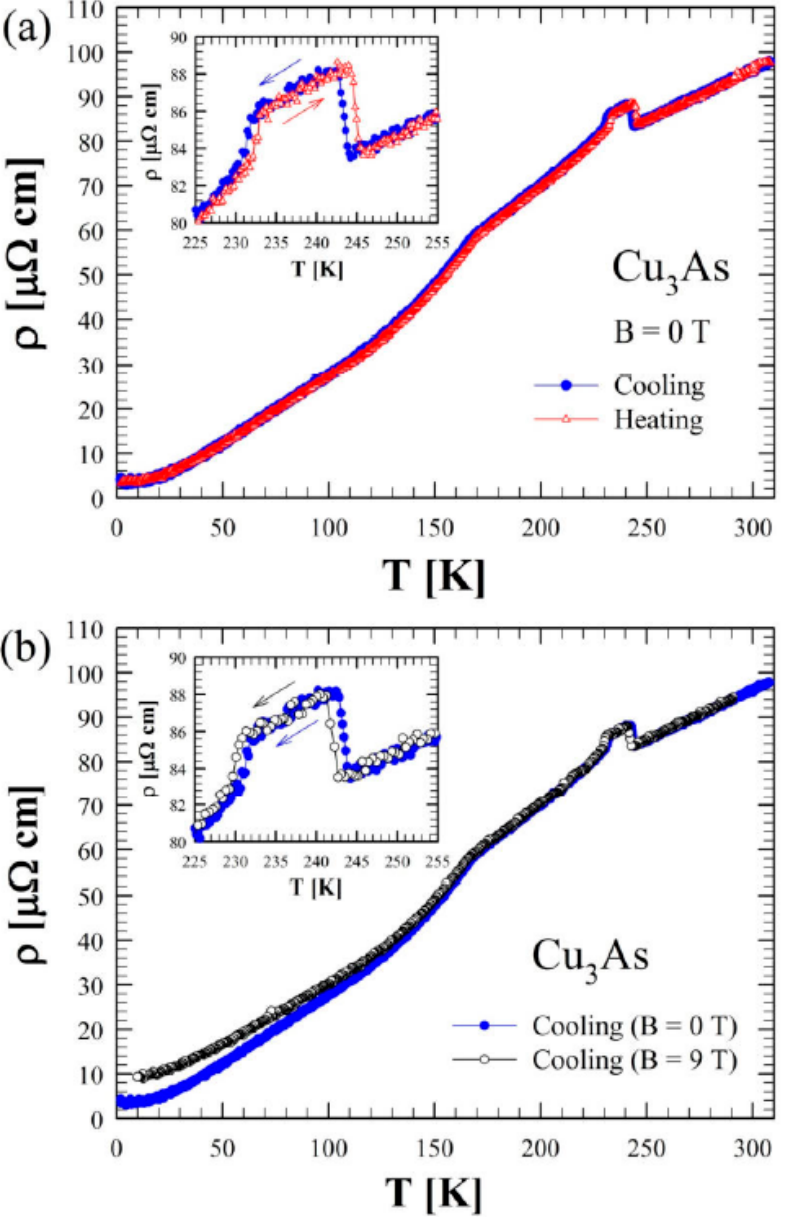
Figure 14. ( a ) Zero-field electrical resistivity as a function of temperature between 2 and 300 K for Cu 3 As measured both on cooling and heating. ( b ) Electrical resistivity measured in zero and under applied magnetic field of 9 T (both on cooling) for Cu 3 As. The insets in ( a , b ) show a magnification of the data between 225 and 255 K.